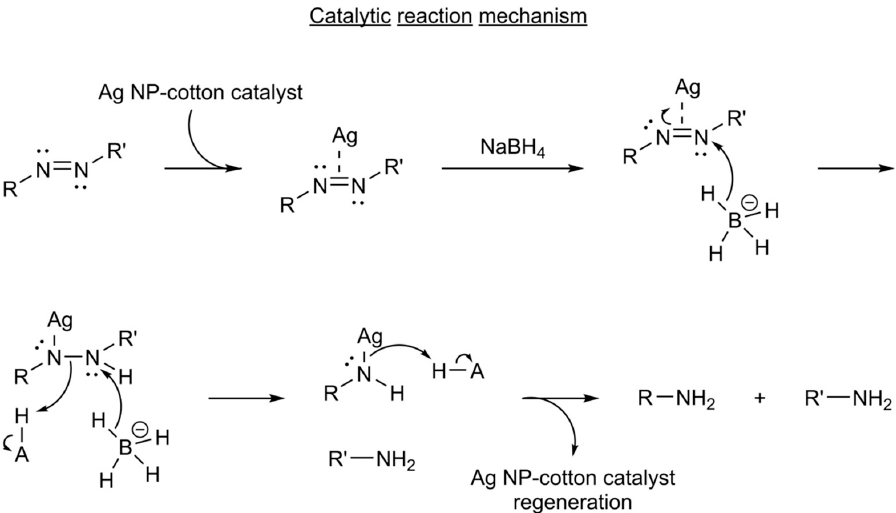
Scheme 1. Plausible mechanism for the Ag-catalytic reduction of azo-dyes by NaBH 4 , where R and R’ represent carbon-based functional groups, and H-A represents water as a proton Table 2. Calculated turnover number (TON) and turnover frequency (TOF) for catalytic dye degra- dation studies using 200 and 400 mg Ag NP–cotton catalyst loading. Ag NP–Cotton Catalyst Dye Loading 0.056 a Calculations based on ≥ 95% dye degradation (linear region). The effect of Ag NP–cotton catalyst concentration was investigated by doubling the catalyst loading to 400 mg. The amount of time to complete the reaction significantly